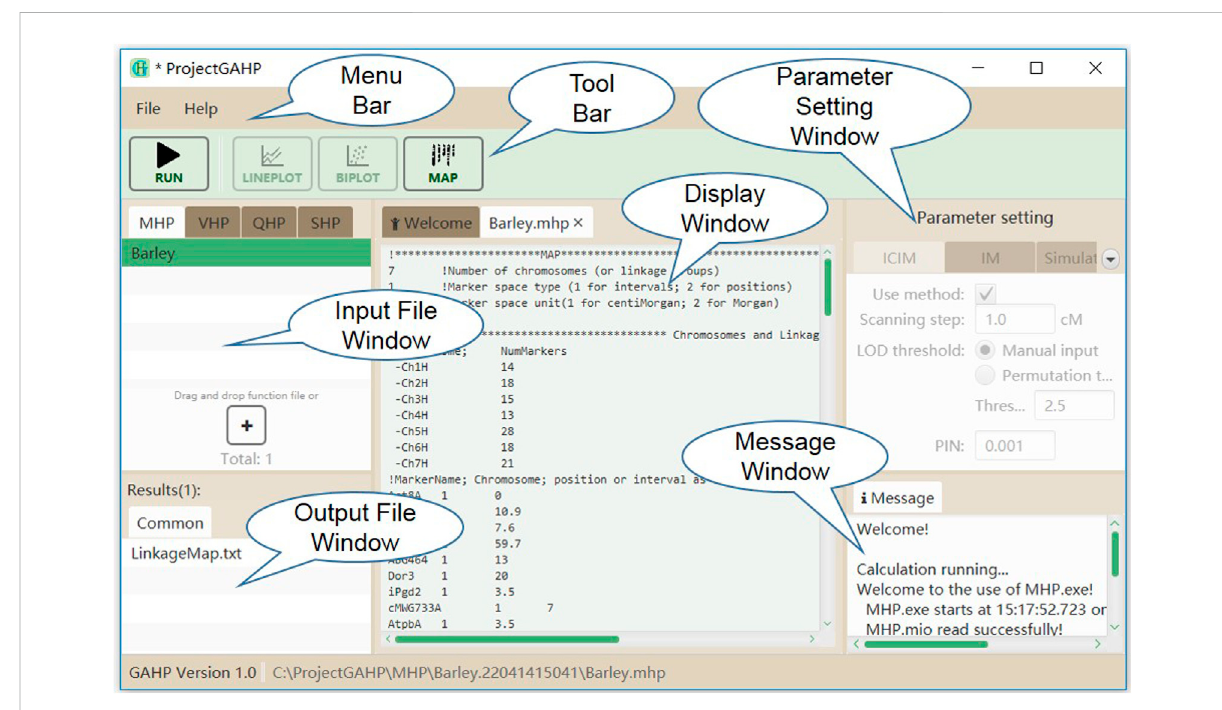
FIGURE 2 The interface of functionality